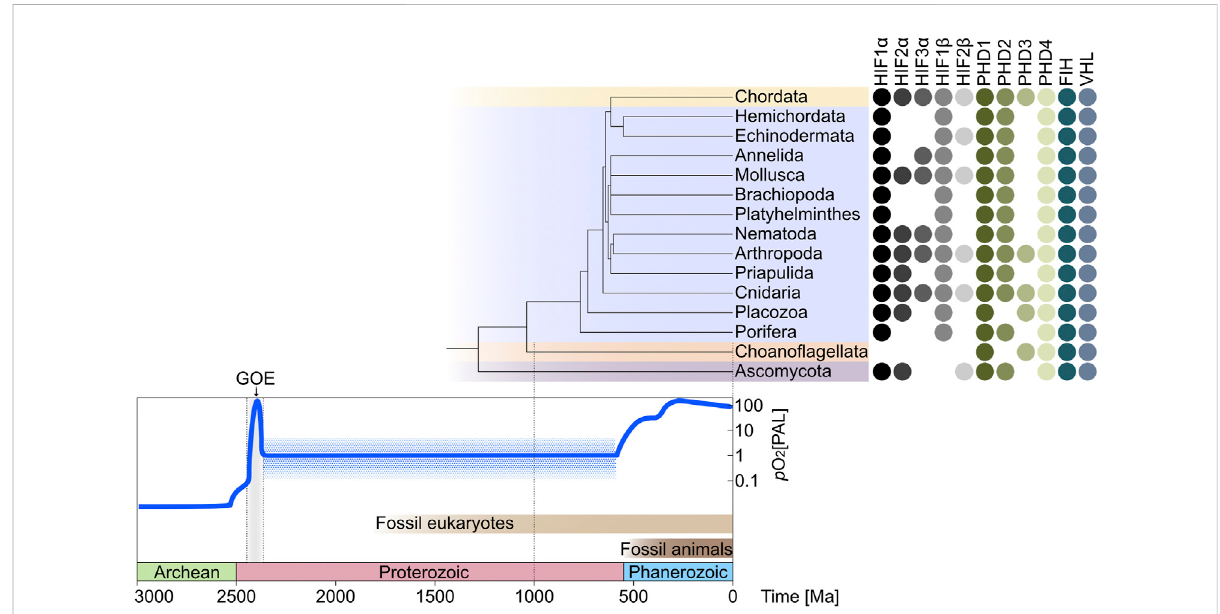
FIGURE 2 The evolution of the main oxygen sensing pathway across metazoans over the Earth ’ s oxygen history. The oxygen curve describes the Earth ’ s oxygen content during each geological time scale (Walker et al., 2018), thedetailed information has been obtained from recent publications (Bekker etal.,2004;Lyonsetal.,2014).Morethan2500 millionyears(Ma)ago,theEarthoxygencontentwasalmostatananaerobicstate(CatlingandZahnle 2020);duringtheProterozoicperiod(2500 – 542 Ma),despitethegreatoxidationevent(GOE)thathappenedatthebeginningofthisperiod,the oxygencontentwasstillverylow witharound1%presentatmosphericlevels(PAL) (Allen etal.,2019);during thePhanerozoicperiod(541 – 0 Ma),the atmospheric oxygen content increased constantly to the modern level (Lenton et al., 2016; Krause et al., 2018). The phylogenetic tree shown in the fi gureisscaledtothetimeframeatthebottomofthe fi gure.Itisconnectedtothepresence-absencepattern(PAP)ofoxygensensinggenes.ThePAP shows the distribution of the 11 gene categories across 13 metazoan phyla (Chordata, Hemichordata, Echinodermata, Annelida, Mollusca, Brachiopoda,Platyhelminthes, Nematoda, Arthropoda,Priapulida, Cnidaria, Placozoa, and Porifera) and two non-metazoan phyla (Choano fl agellata andAscomycota)thatinclude566species(SupplementaryTableS2).Theoxygensensingregulators(HIF1 α ,HIF2 α ,HIF3 α ,HIF1 β ,andHIF2 β )attheleft of the PAP are the substrates of the oxygen sensors (PHD1, PHD2, PHD3, PHD4, and FIH) in oxygen-dependent reactions before the ubiquitination (Ub)ofthetumorsuppressorgene(VHL).(HIF — hypoxia-induciblefactor;PHD — HIFprolylhydroxylases;FIH — factorinhibitingHIF;VHL — vonHippel Lindau tumor